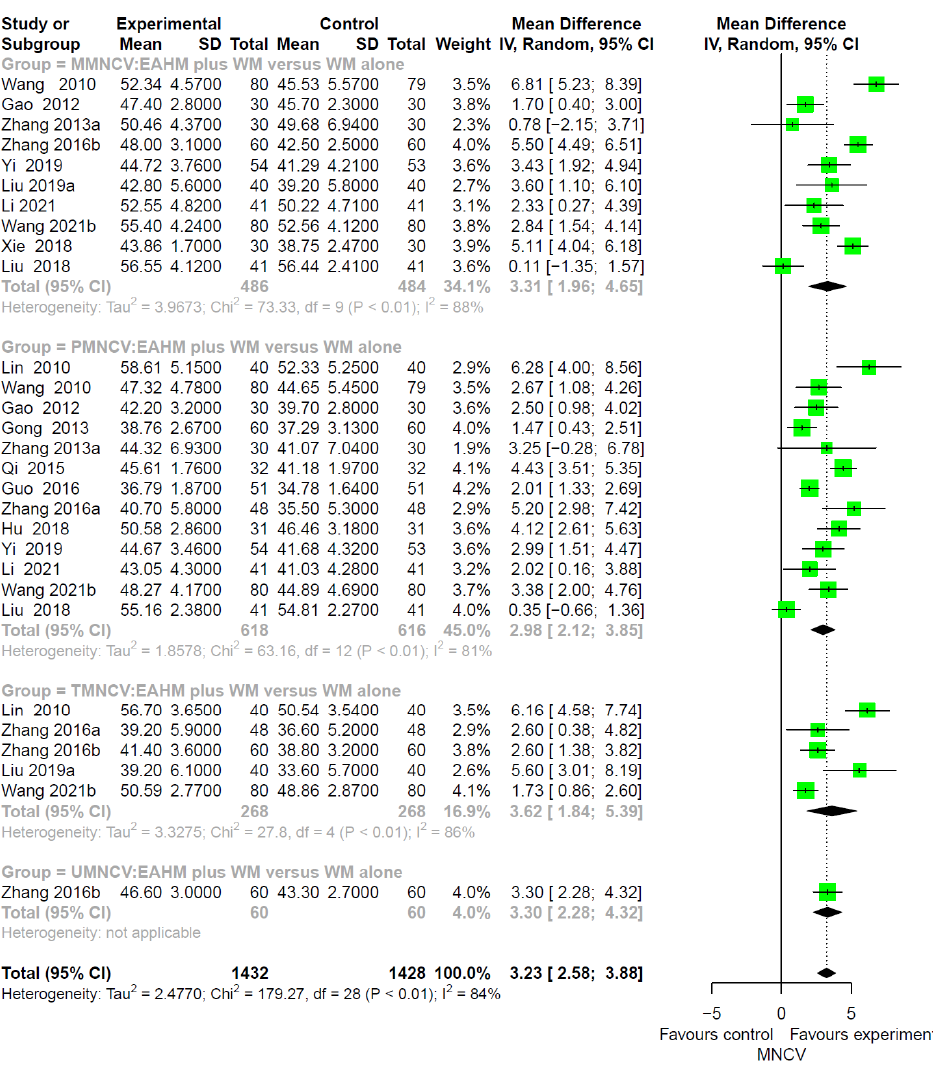
Figure 6. Forest plot of the trials reporting the effect of combined East Asian herbal medicine and western medicine therapy on motor nerve conduction velocity for peripheral neuropathy.